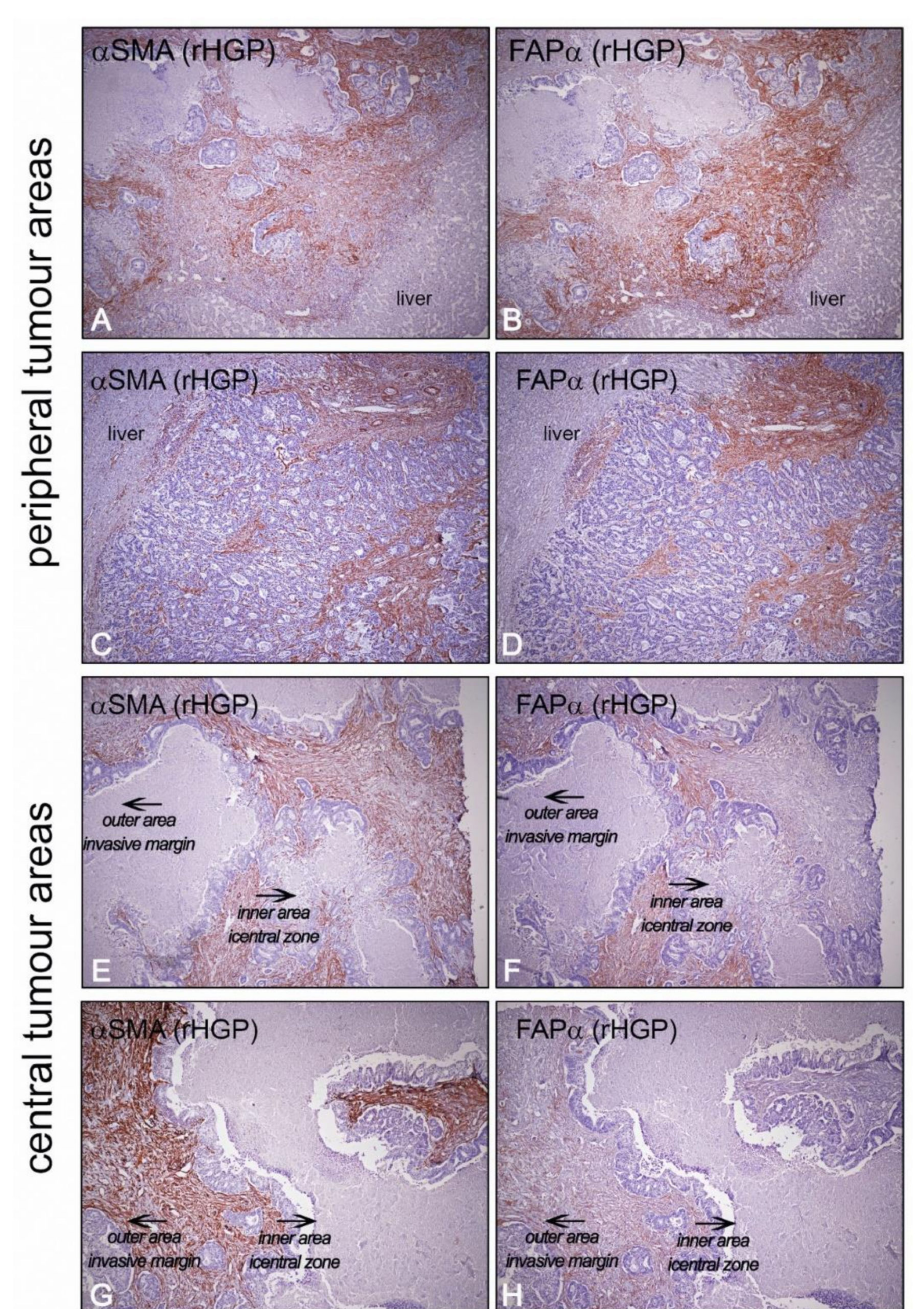
Figure 2. Different cancer-associated fibroblast (CAF) subsets might be topographically located in particular areas inside the LM-CRC. Although it is a fact that should be explored in detail with dedicated technologies such as spatial transcriptomics, invasive margins ( A – D ) displayed an intense staining of both α SMA and FAP. The outer regions of the liver metastases are those areas where there is a constant tissue remodeling and where tumor cells show more aggressive phenotypes, higher proliferation and migration capabilities. On the contrary, in central areas of the tumor ( E – H ), having the liver–tumor interface as a reference, a progressive decrease in FAP staining is observed, becoming negative in the most central and internal areas of the tumor. The staining of α SMA is quite homogeneous. These areas usually correspond to areas of secondary fibrosis enriched in myofibroblasts, probably corresponding to myCAFs. These areas are progressively repaired as the tumor grows. In these areas, the activation pattern of CAFs is different from those closest to the invasive margin (rHGP stands for the replacement histologic growth